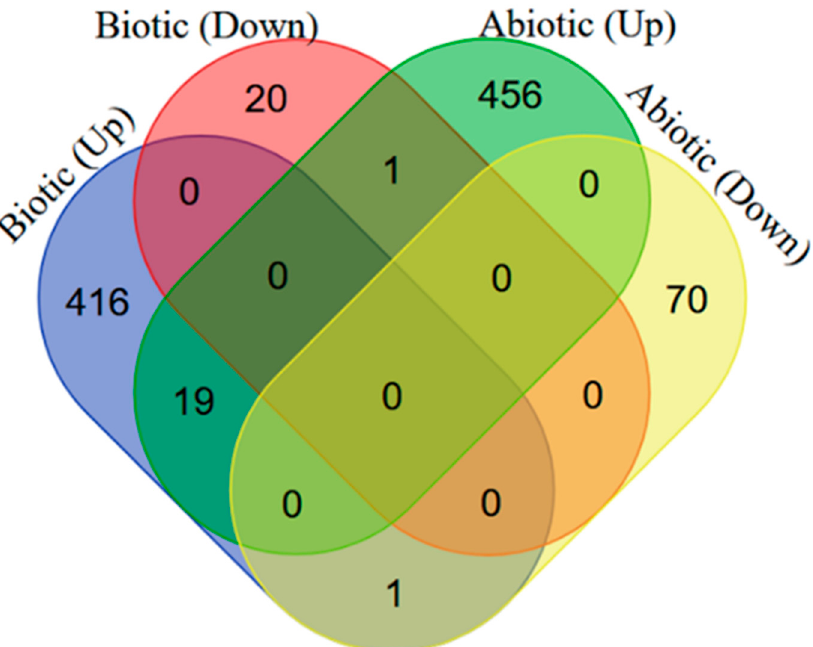
Figure 1. Identification of genes involved in biotic and abiotic stresses. Comparison of differentially expressed genes (DEGs) during abiotic and biotic stress responses. Four-way Venn diagrams showing co-occurrence and up-/downregulation of DEGs in response to various abiotic and biotic stresses.